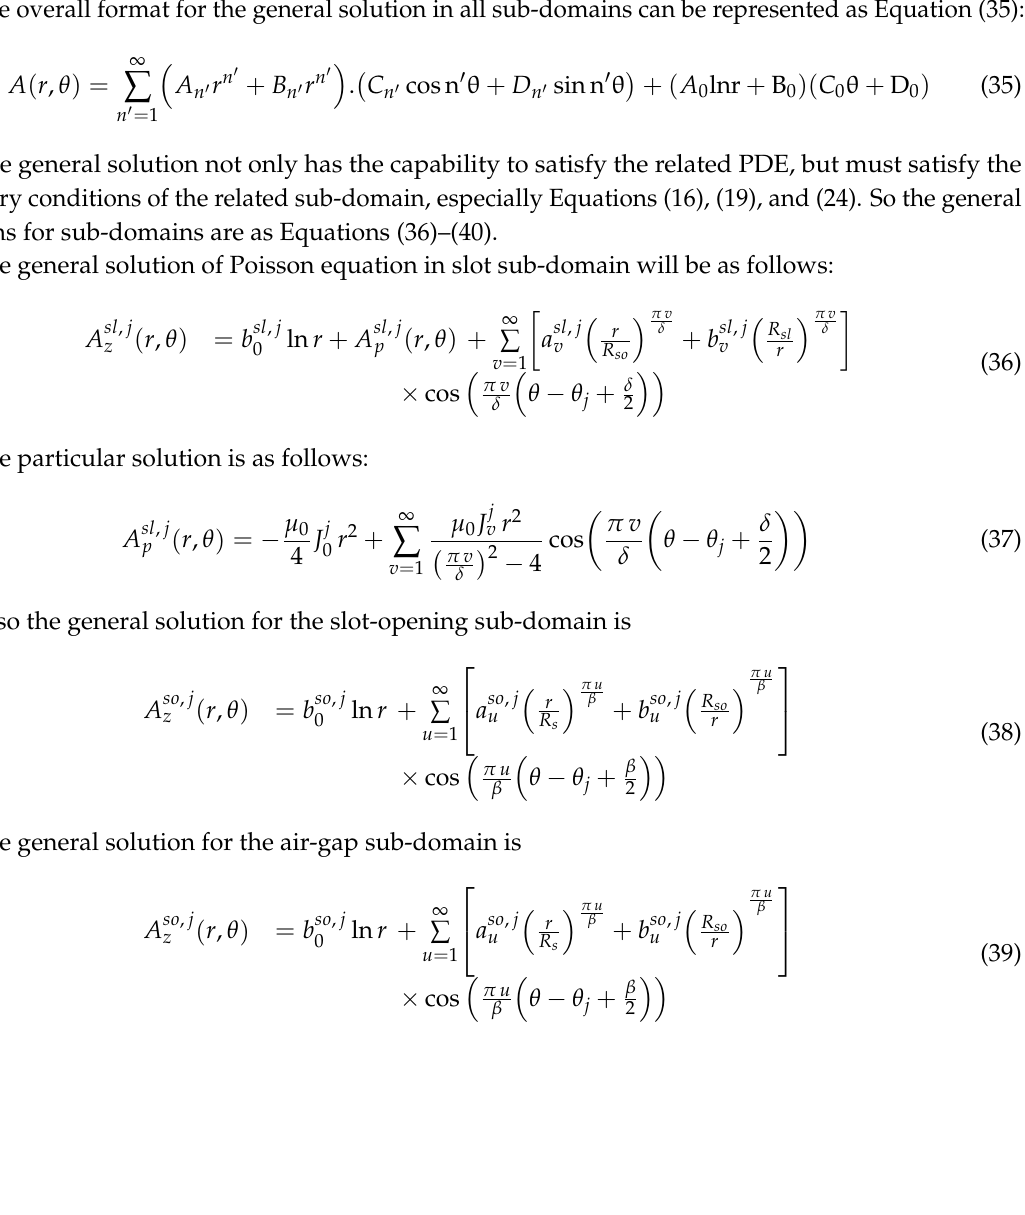
Table 3. Radial magnetization pattern and its Fourier series